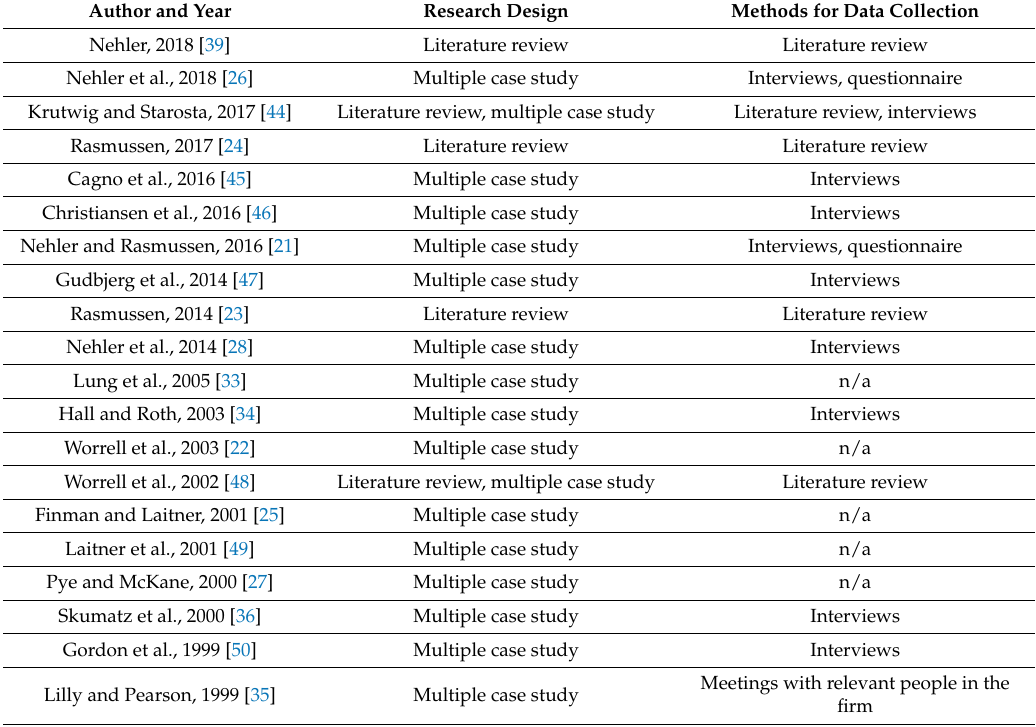
Table 3. Methodological approach applied in the observation of non-energy benefits in the reviewed publications in the area of non-energy benefits in industry. n/a—not